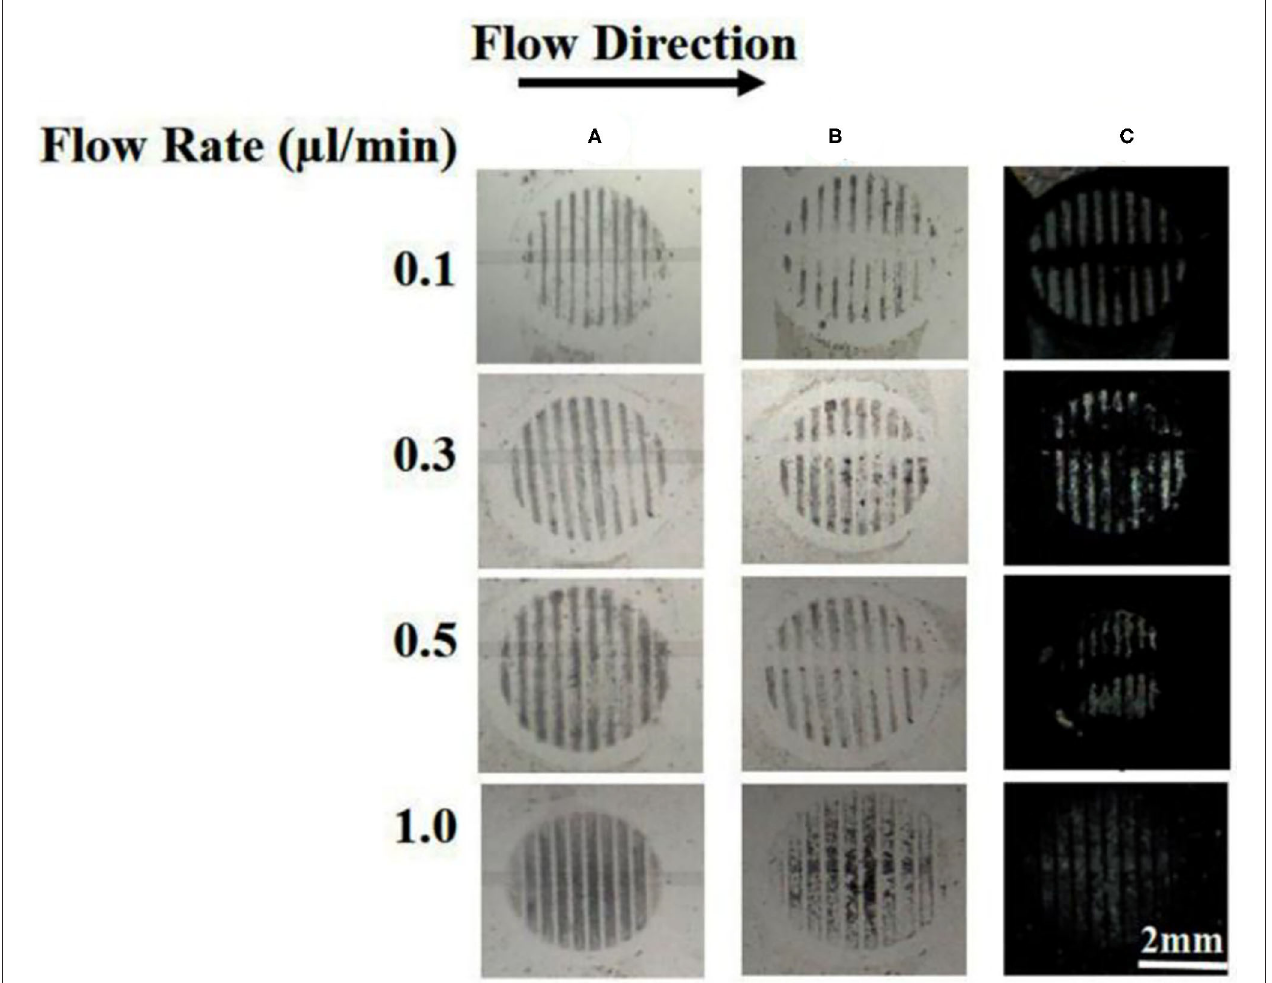
FIGURE 6 | Effect of flow rate on the removal of surface-immobilized gp-120 from a DMOAP-coated surface by using B40t77. (A) Before flowing B4077 solution. (B) After flowing B40t77 solution at different flow rates (0.1, 0.3, 0.5, and 1 µ l/min). (C) Optical images of LC after the assay was completed. The B40t77 concentration used was 16 µ l/ml and the sample volume was 15 µ